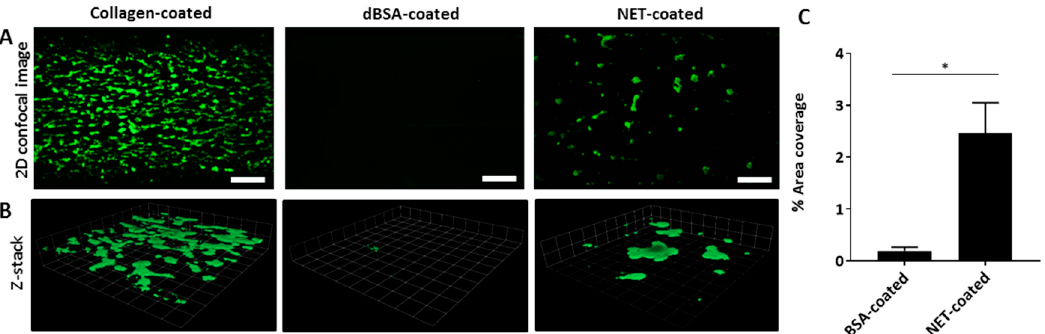
Figure 7. NETs entrap and activate platelets and promote thrombus formation. ( A ) 2D confocal images of platelet adhesion and thrombus formation in collagen-, dBSA-, and NET-coated channels after perfusing DiO6C(3) fluorescently-labelled whole blood for 10 min at 10 dyne/cm 2 . Platelet adhesion and thrombi are visualised in NET-coated channels. Collagen- and dBSA-coated channels served as positive and negative controls, respectively. Scale bar = 90 µ m; ( B ) Z -stack images confirm the presence of thrombi on NETs, which are similar to those in collagen-coated channels; ( C ) Quantification of surface area coverage of platelet adhesion showed a significant increase in NET-coated channels. n = 3, * p < 0.05 unpaired t -test.